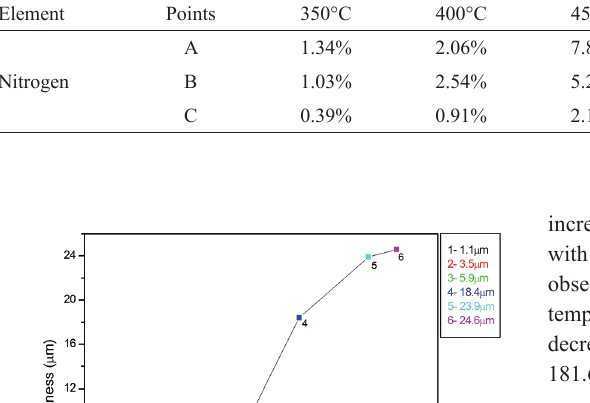
Table 2: Chemical composition along the layer at points A, B and C Element